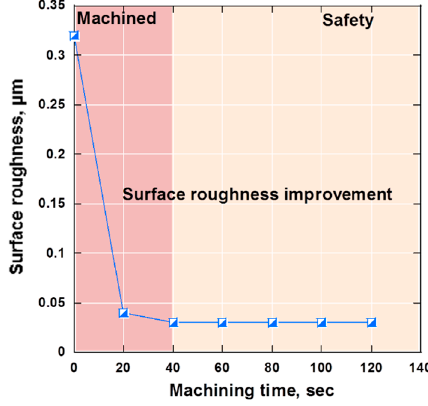
Figure 8. Variations in surface roughness vs. machining time at 80,000 rpm (10 Hz, 550 mT, and 0.5 µm).